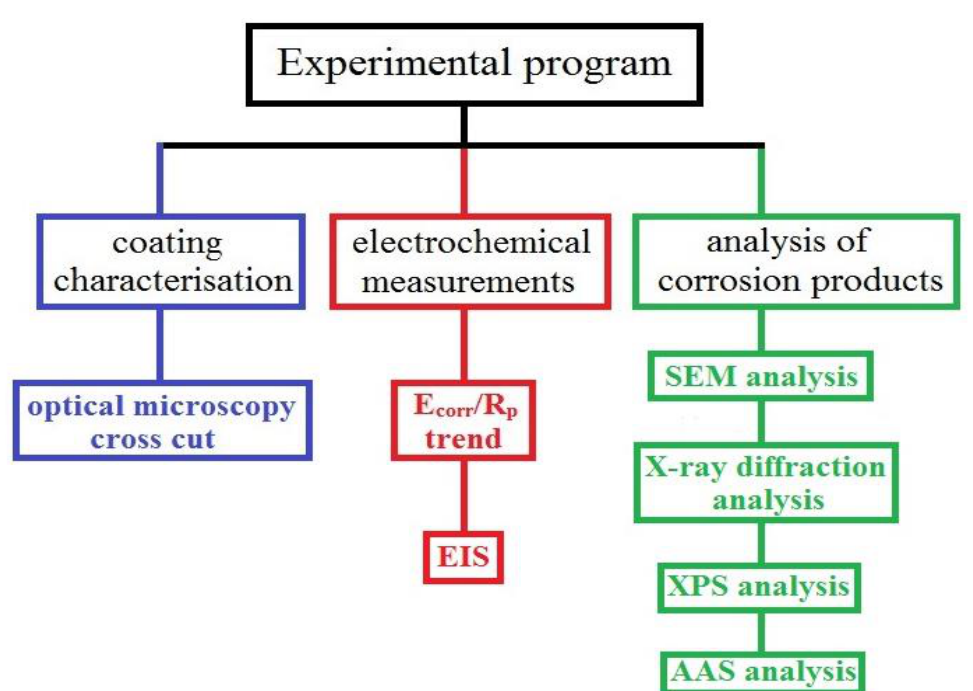
Figure 1. Flow chart of experimental program of this study.